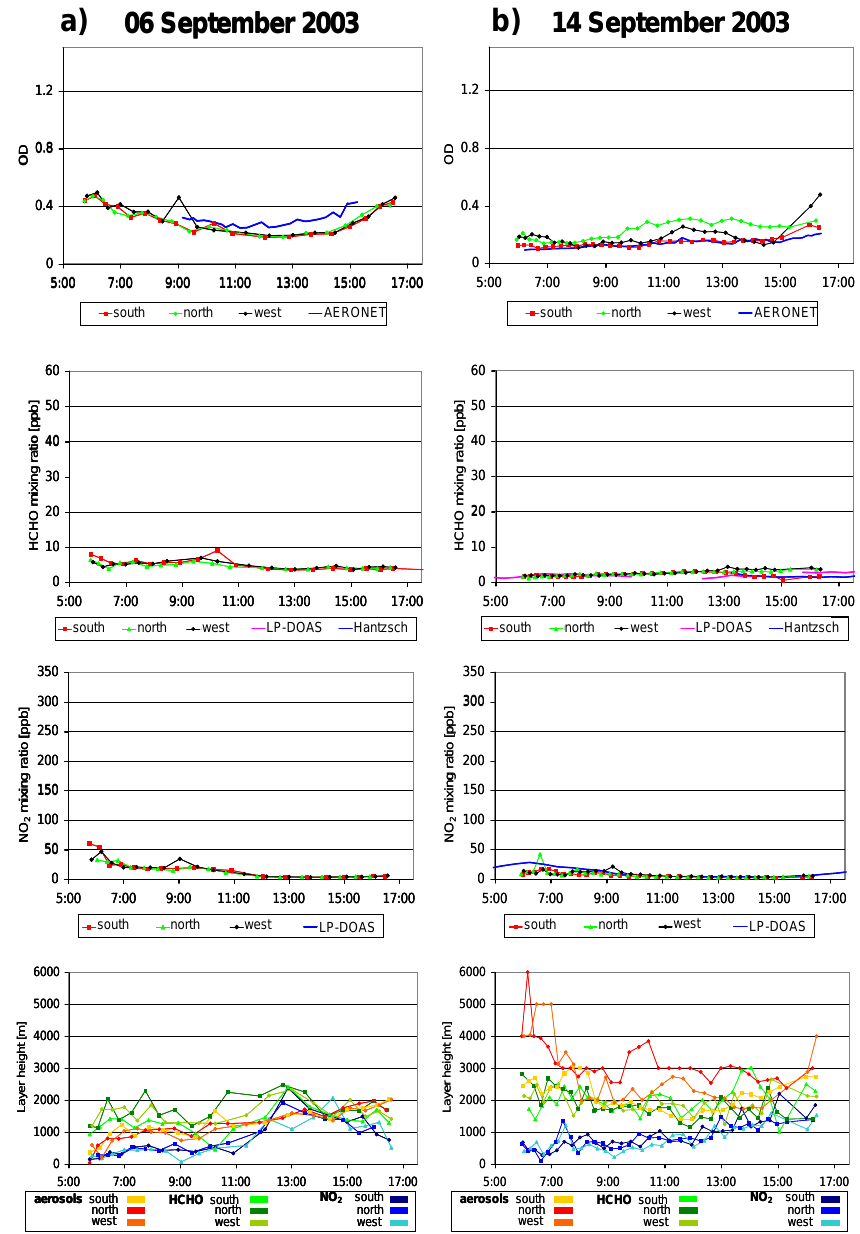
Fig. 15. Retrieval results of the AOD, mixing ratios of HCHO and NO 2 , and layer heights from individual elevation sequences for selected days. Also the results for the LP-DOAS and Hantzsch instrument and the AERONET AOD (at Ispra) are shown for